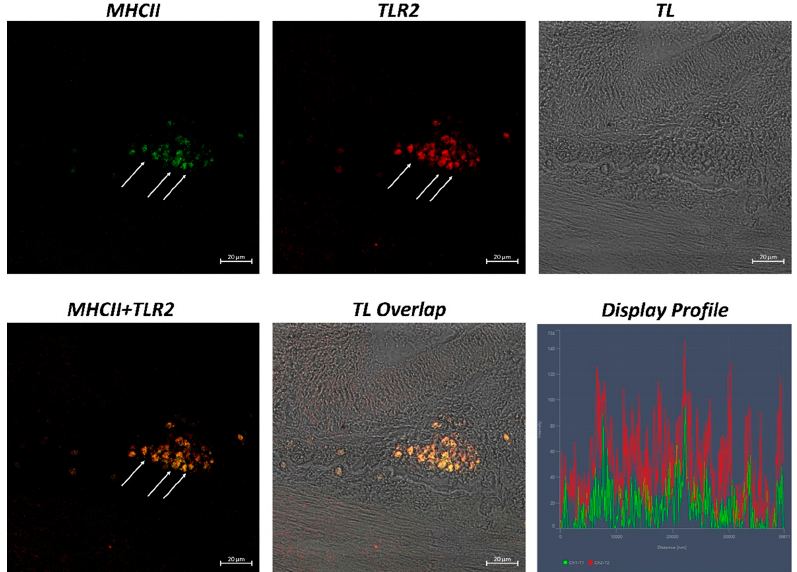
Figure 1. Section of the H. niloticus gut (immunofluorescence 40 × , scale bar 20 µ m). Macrophages that are positive for TLR2 and MHC II can be noted in the lymphoid tissue aggregates (marked by arrows). The “Display profile” function highlights the colocalization. TL = transmitted light.